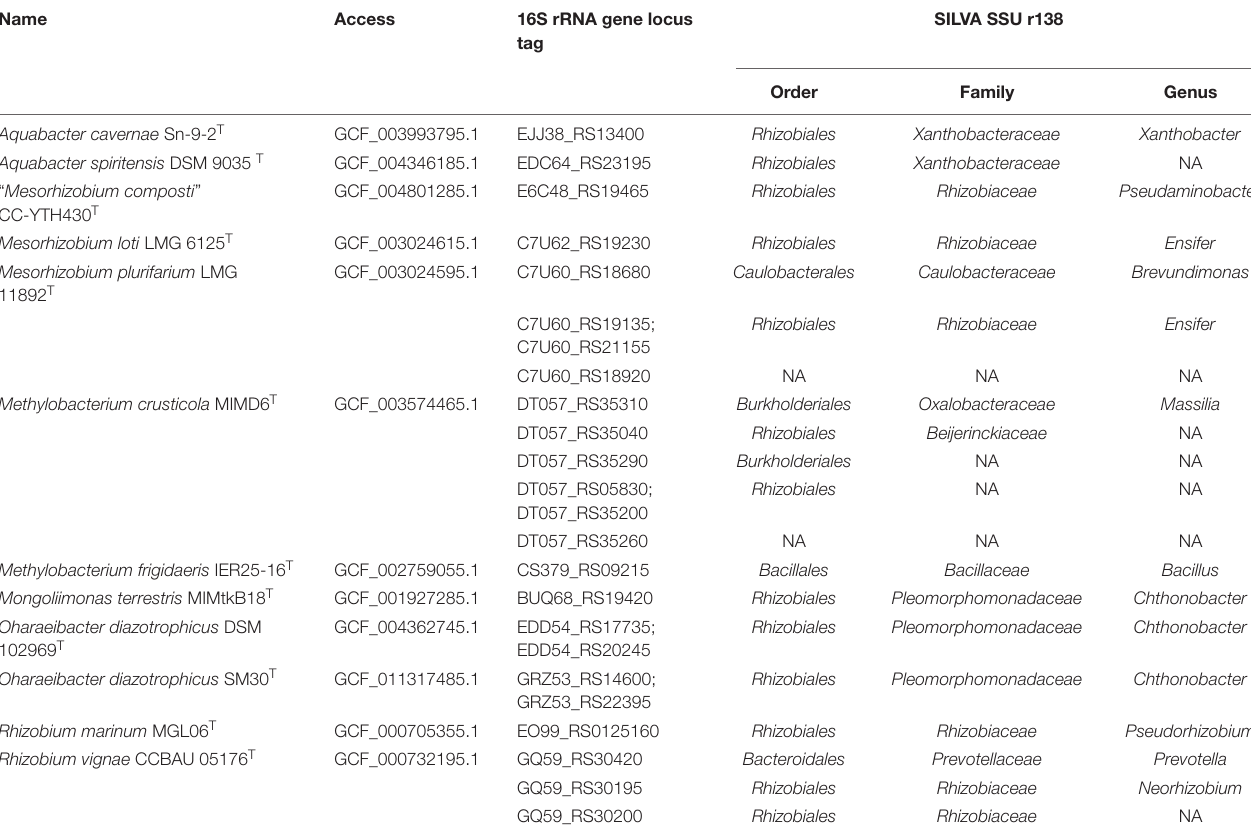
NA, not available. TABLE 2 | 16S rRNA copies extracted from genomes and incorrectly taxonomically